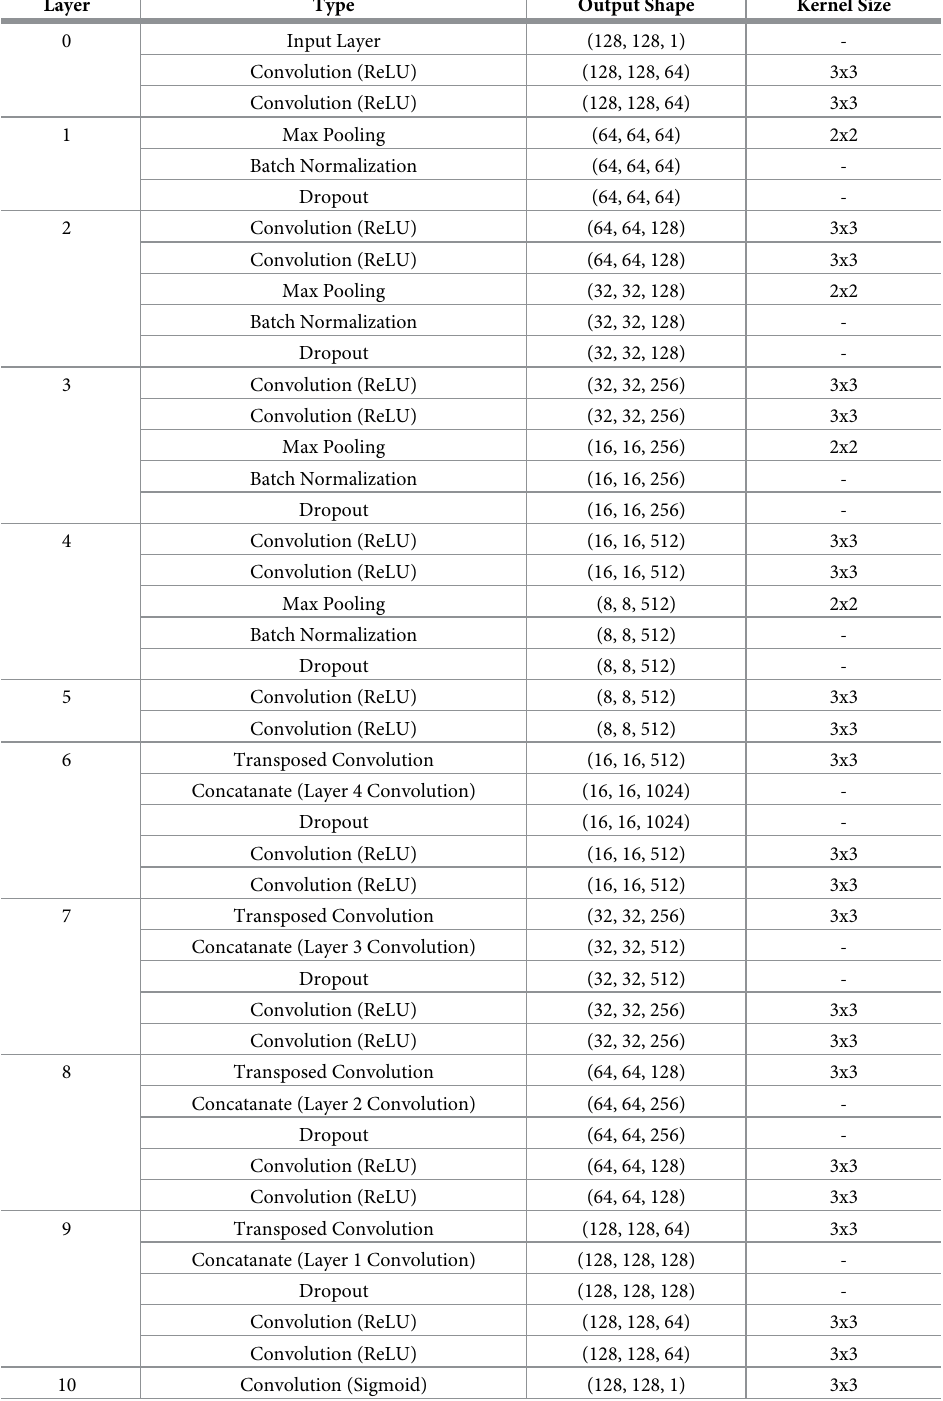
Table 2. Infection segmentation model: